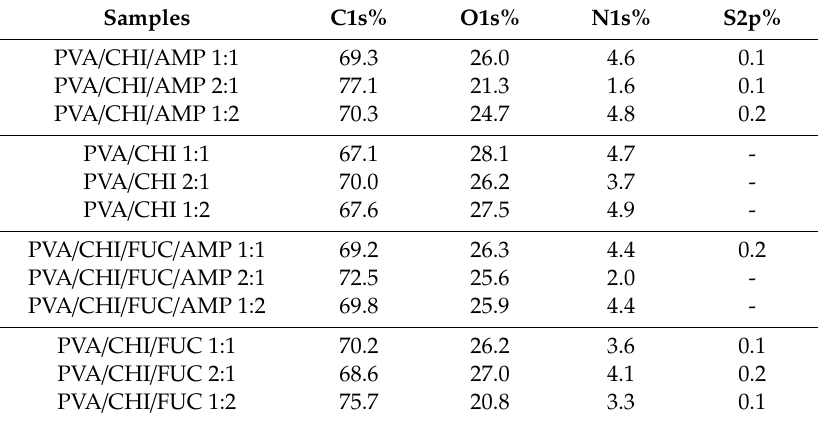
Table 2. List of the XPS spectra given in atomic percent of all the